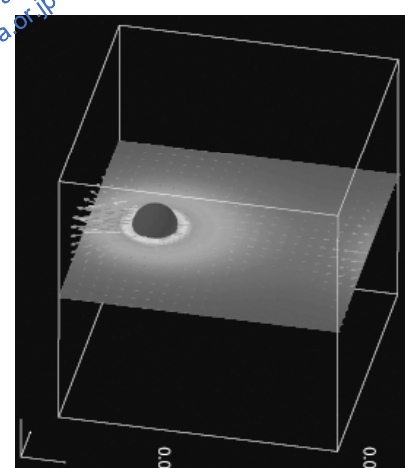
Fig. 3 A colloidal particle (colored blue) in electrophoretic motion un- der an external electric field applied in the + x direction; in the figure, light and shade represent the electric charge density dis- tribution and the arrows the solvent velocity fields.